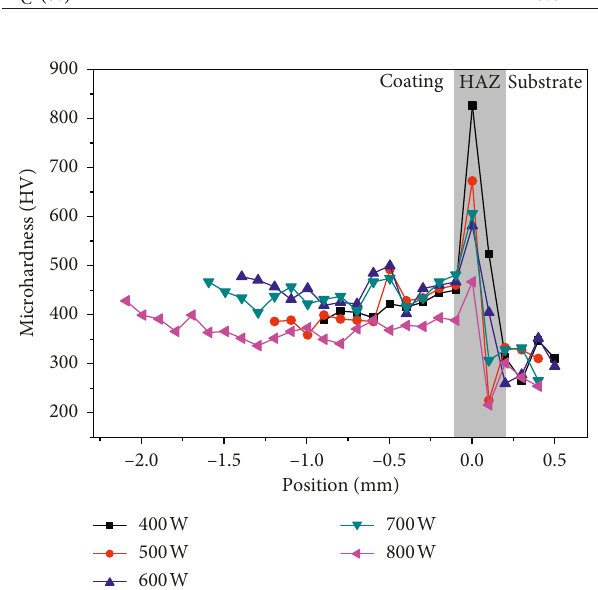
Figure 12: Microhardness distribution of coatings prepared under different laser output powers.